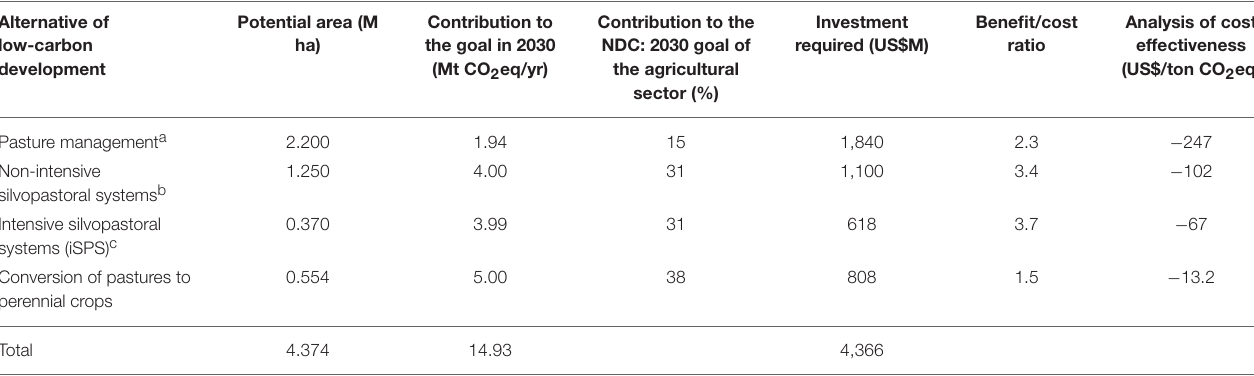
TABLE 3 | Alternatives of low-carbon development in the livestock sector, their contributions to the reduction of emissions, and their economic characteristics (MADR, 2018). Alternative of low-carbon development